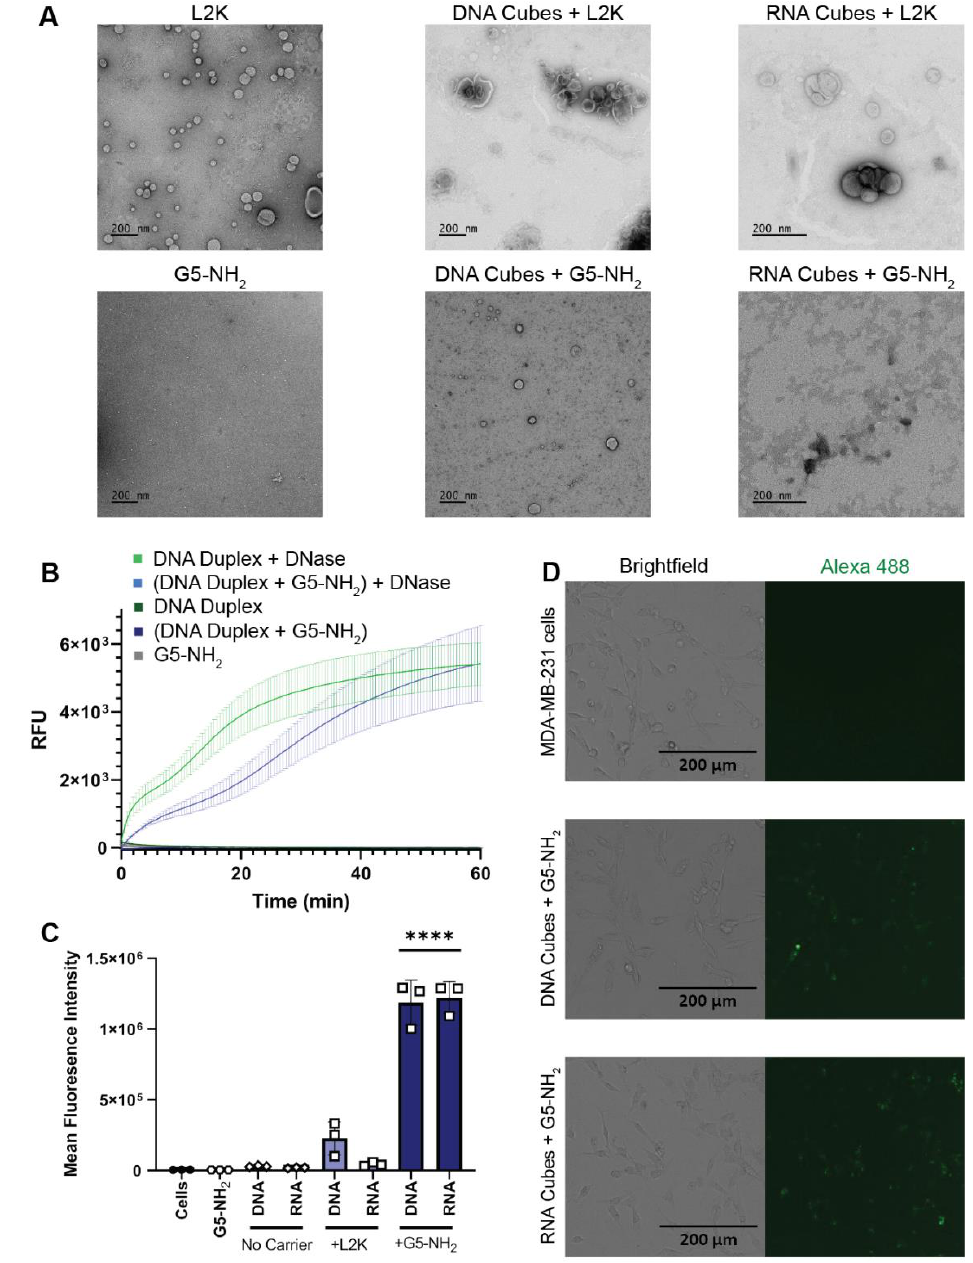
Figure 3. NANPs complexed with G5-NH 2 dendrimers. ( A ) Transmission electron microscopy images of Lipofectamine 2000 (L2K), G5-NH 2 dendrimers, and DNA and RNA cubes complexed to either L2K or G5-NH 2 dendrimers. ( B ) Resulting fluorescence profiles from nuclease resistance assays. ( C ) Mean fluorescence intensity associated with the in vitro uptake of Alexa 488-labeled DNA and RNA cubes in MDA-MB-231 cells. Each bar shows the mean response and standard deviation ( N = 3). Statistical significance between the DNA and RNA cubes delivered with G5-NH 2 versus all other treatments is denoted by **** where p < 0.0001. ( D ) Brightfield and GFP microscopy images of MDA-MB-231 cells transfected with DNA cubes complexed to G5-NH 2 dendrimers and RNA cubes complexed to G5-NH 2 dendrimers.